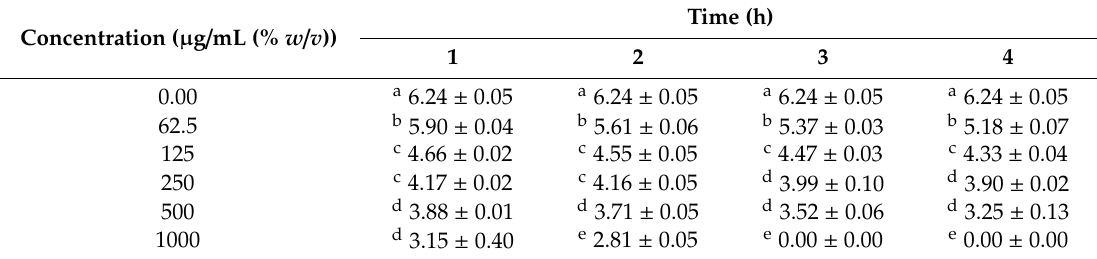
Table 5. The sporicidal activity of β -asarone against spores of B. pumilus ATCC14884. Concentration ( µ g / mL (% w / v ))